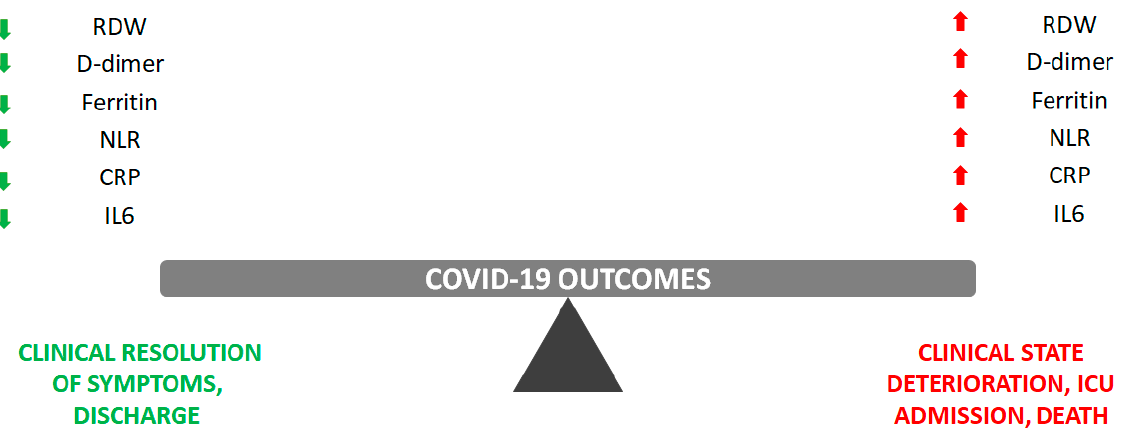
Figure 1. Summary of the most clinically used biomarker (RDW, D-dimer, ferritin, NLR, CRP, and IL6) trajectories in predicting COVID-19 disease evolution.